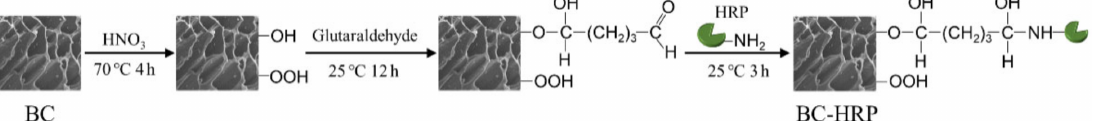
Figure 2. Procedure of covalent immobilization of HRP onto